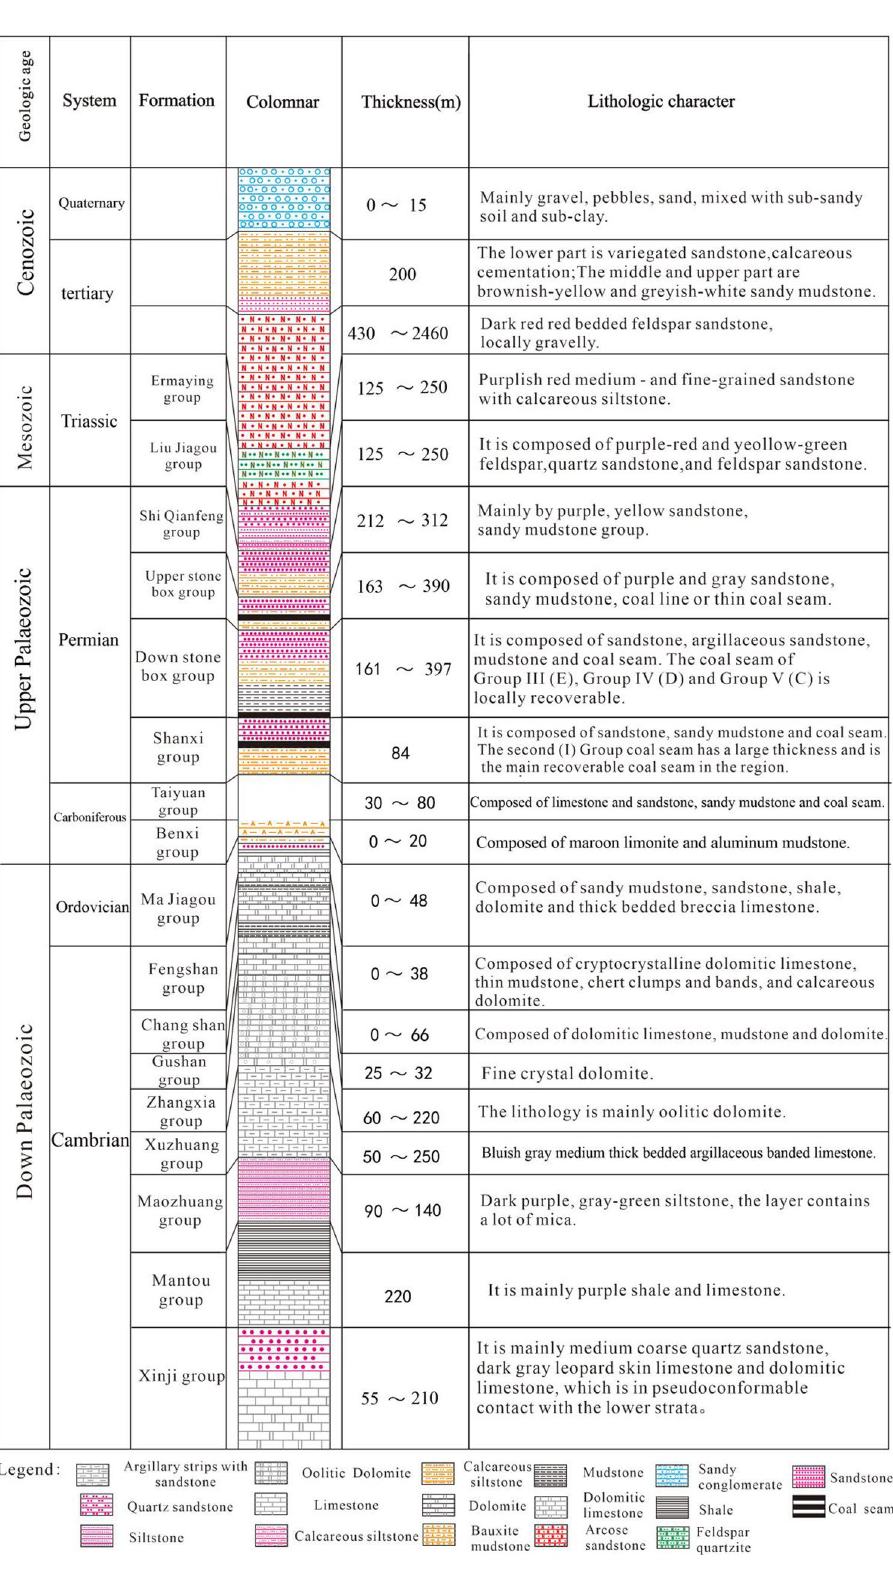
Figure 2. Comprehensive histogram of strata in the Pingdingshan